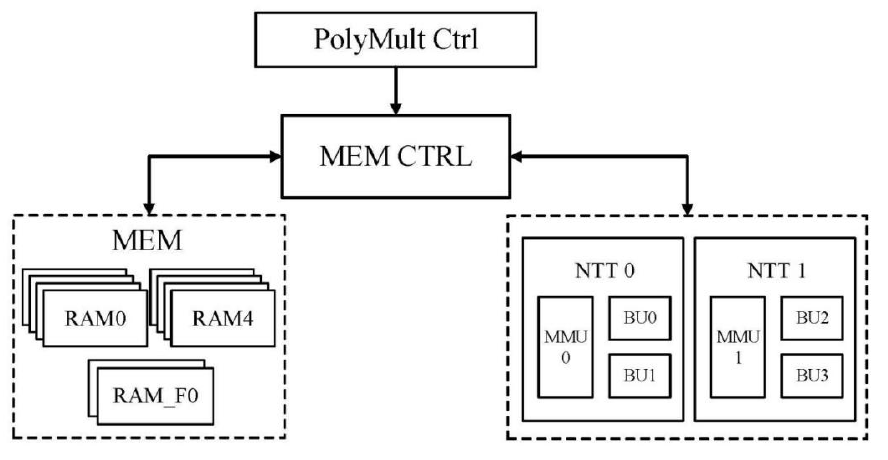
Figure 7. Polynomial multiplier overall